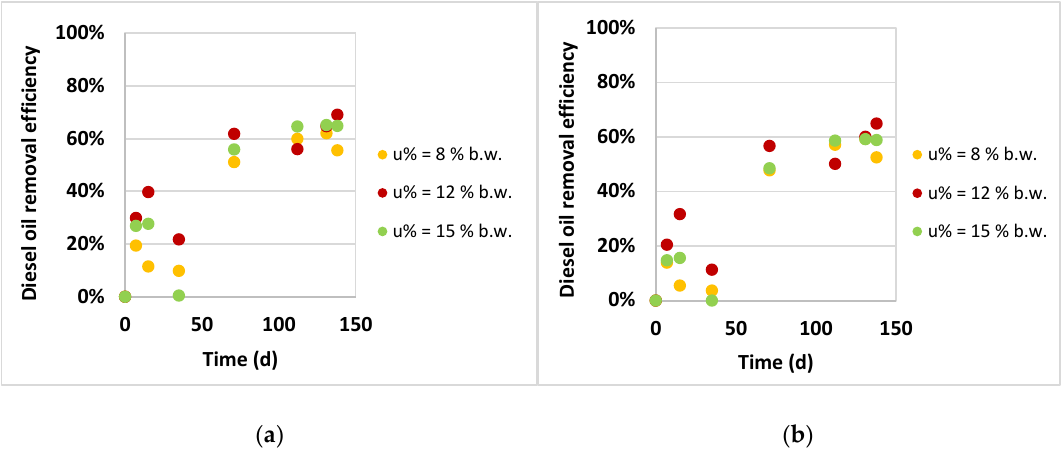
= 70 g · kg − 1 of soil; ( b ) C 0 0 was measured.